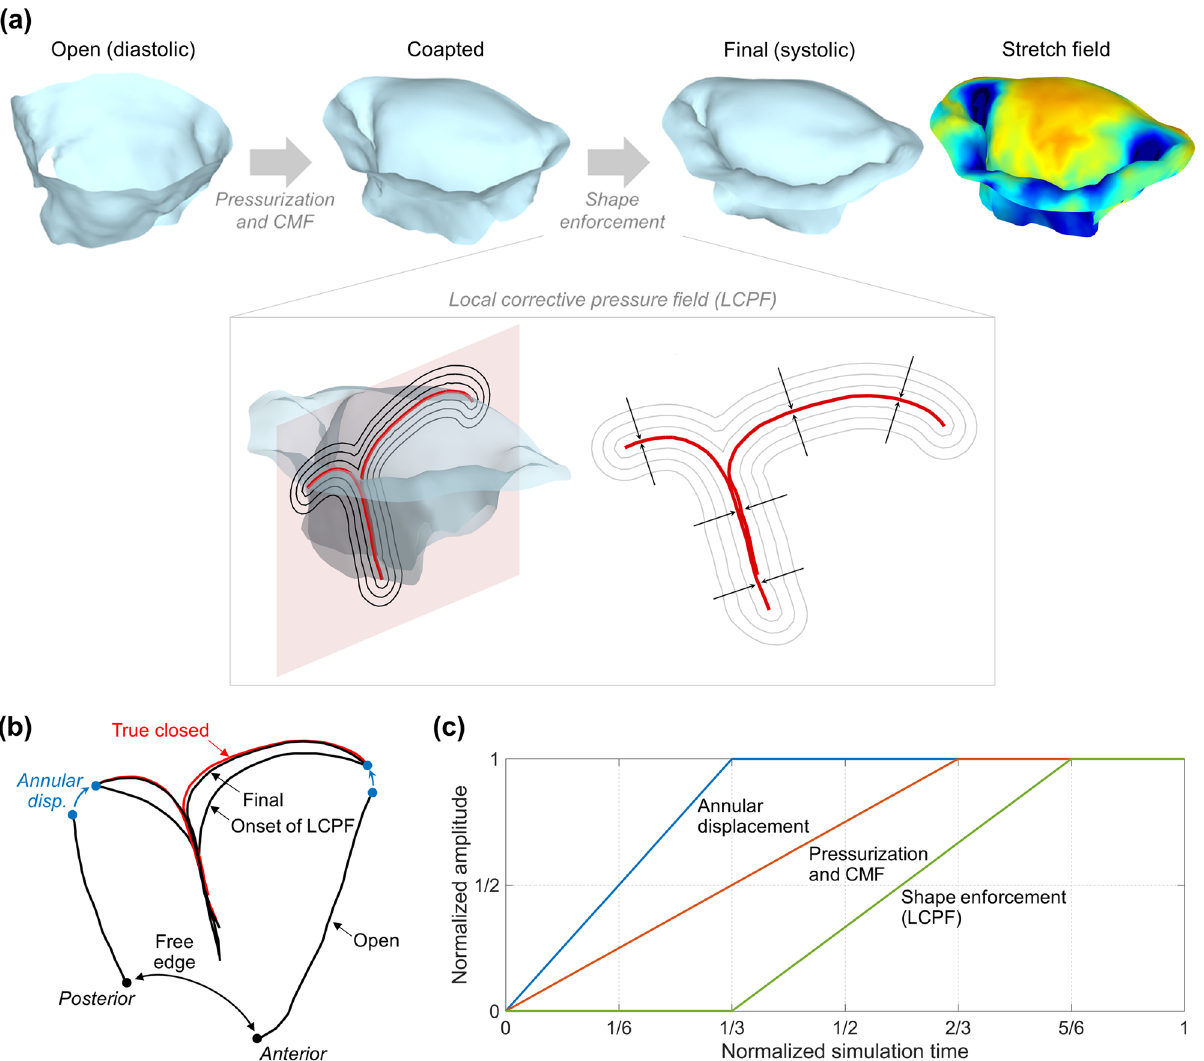
Figure 12. ( a ) Snapshots of a simulated MV throughout a FE closure simulation, showing initial coaptation by pressurisation followed by shape enforcement using the LCPF, resulting in a locally computed stretch field. The LCPF causes the MV mesh to be pushed locally and orthogonally toward the imaged final configuration, thus enforcing the overall shape without biasing local stretch estimates (see Rego et al. 20 for details). ( b ) Snapshots of a cross section of the simulated mesh, shown for the same time points as in ( a ); a cross section of the true closed shape (red) is shown for comparison with the final configuration. ( c ) Coordination of the boundary conditions and loads that are applied during the FE simulation to ensure proper closure and shape enforcement (adapted from Rego et al. 20